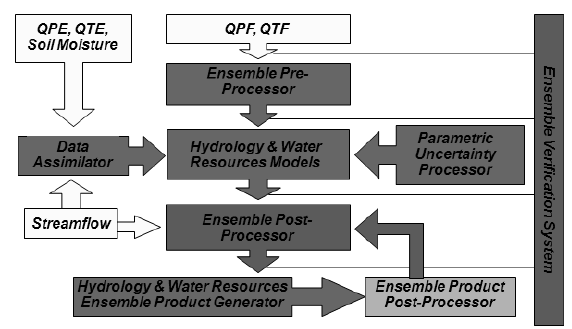
Fig. 1. A schematic of the ensemble streamflow prediction (ESP) system. QPE and QTE stand for quantitative precipitation esti- mation and quantitative temperature estimation, respectively, while QPF and QTF stand for quantitative precipitation forecast and quan- titative temperature